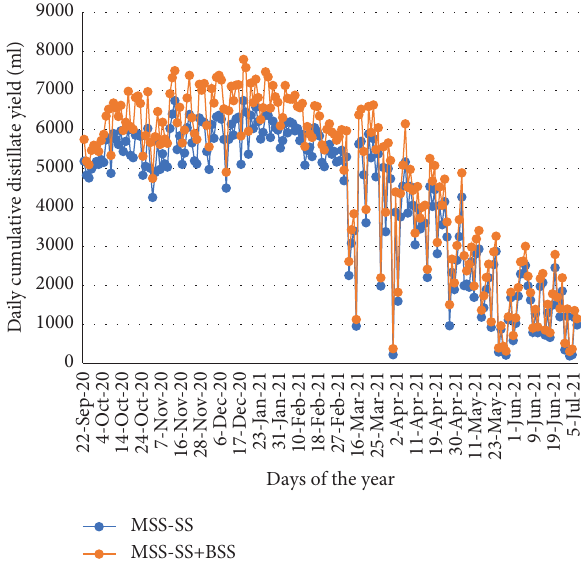
Figure 16: Year-round daily cumulative distillate yield